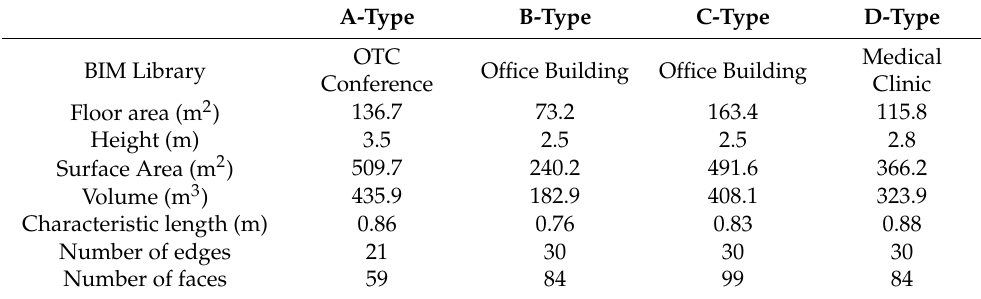
Table 3. Geometric information of target